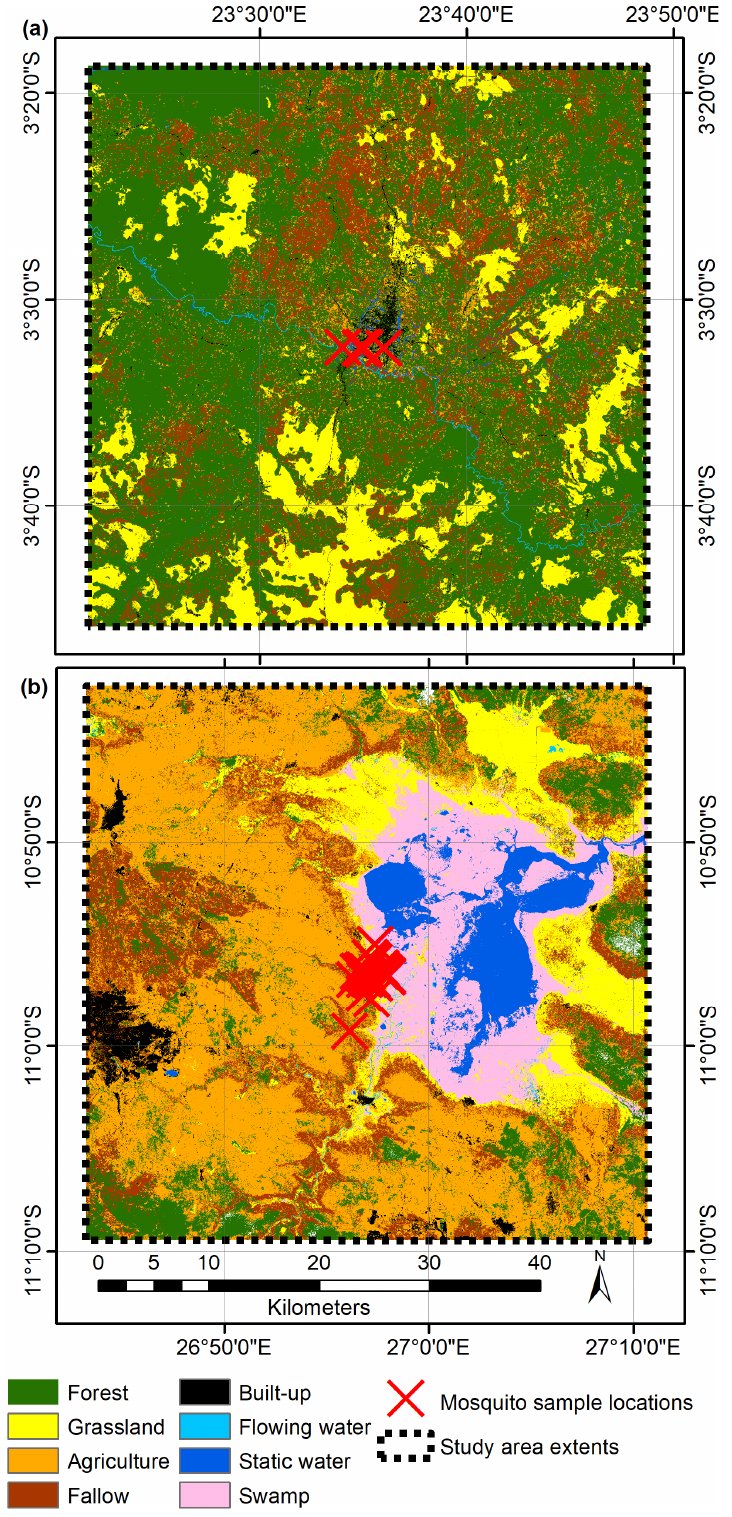
Figure 5. Land cover classifications for the extents of the 50 km × 50 km study area in ( a ) Lodja and ( b ) Kapolowe. ( b )